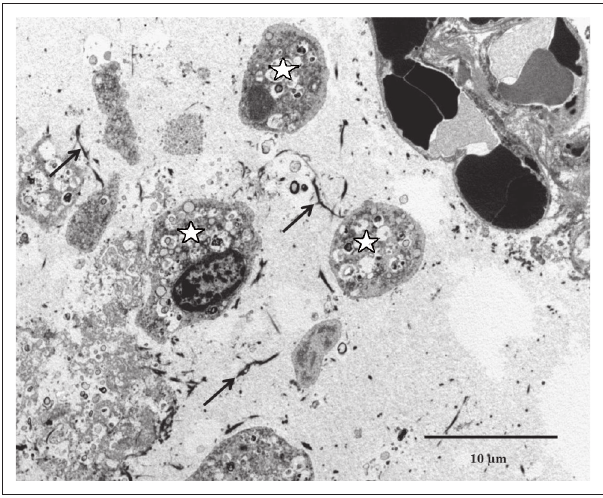
Source : Image taken by Erna van Wilpe FIGURE 6: Fibrin deposits (arrows), desquamated pneumocytes (stars) and cellular debris in the alveolar lumen (EM).